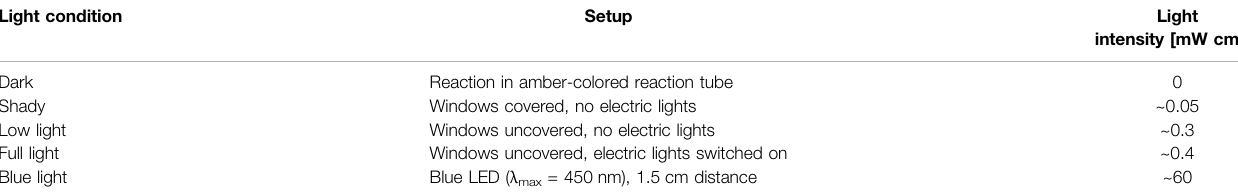
TABLE 2 | Light conditions tested in different setups with respective light intensities. Light condition